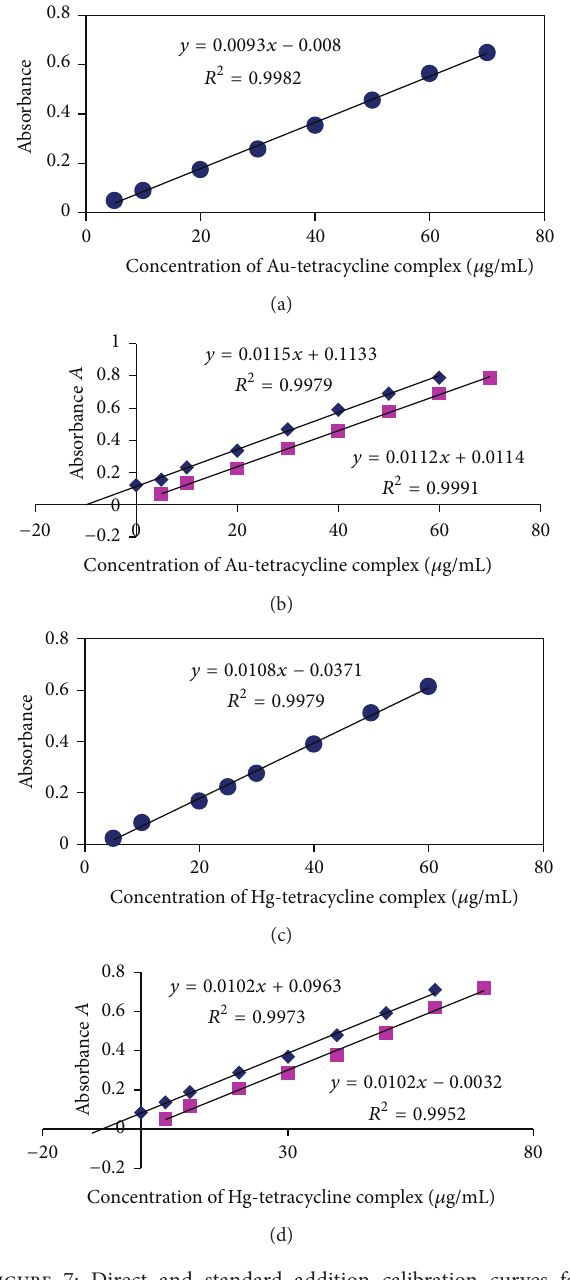
Figure 7: Direct and standard addition calibration curves for determination of TC-Au(III) and TC-Hg(II) complexes by spec- trophotometric methods at 𝜆 max 425 and 320 nm, respectively.